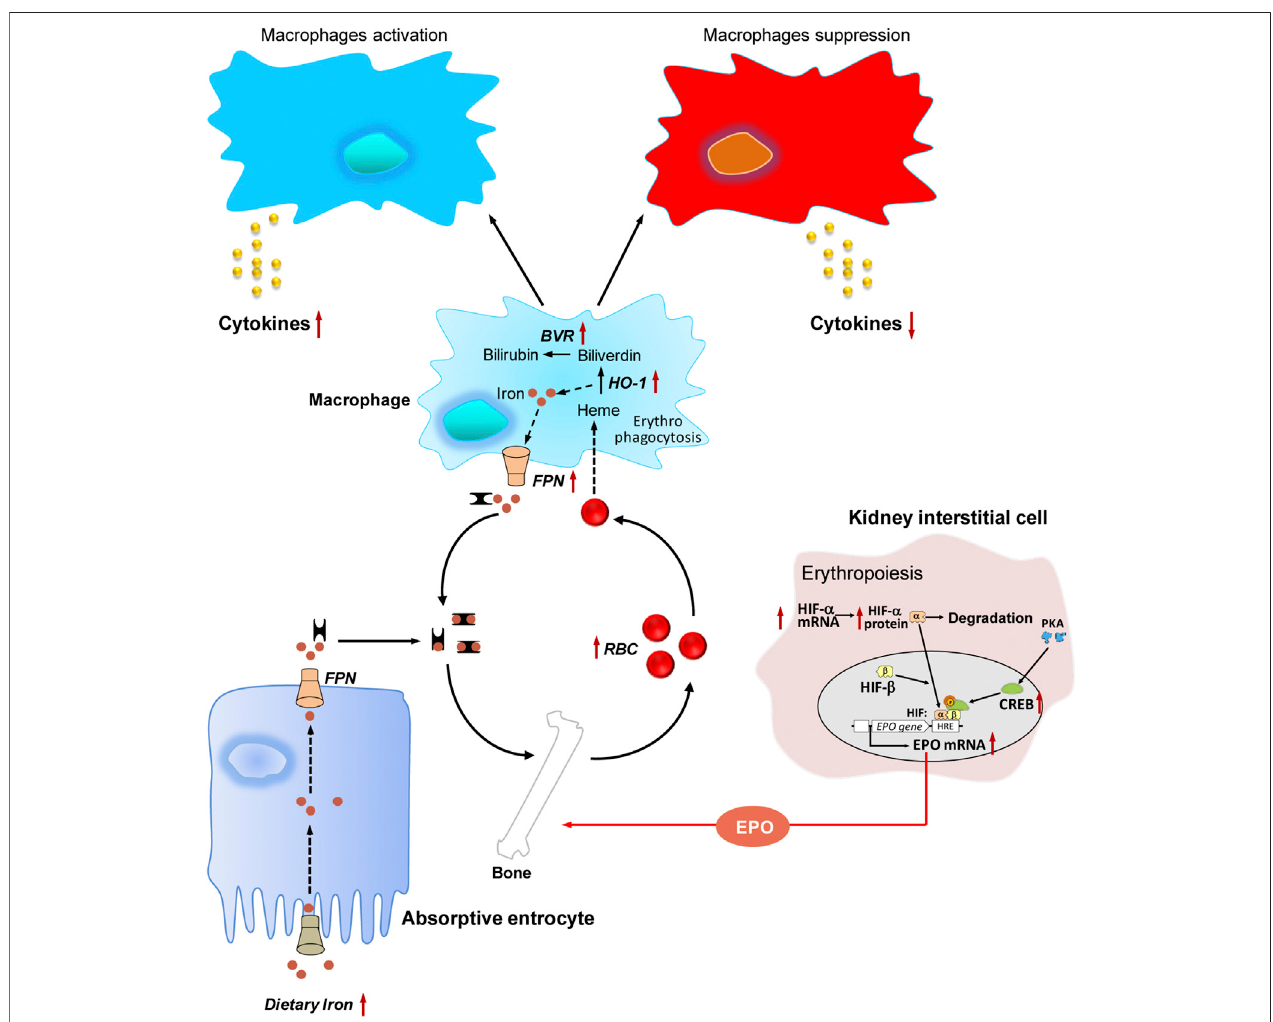
FIGURE 4 | The hematopoietic functions of jujube. Jujube promotes erythropoiesis via activation of hypoxia inducible factor-induced erythropoietin, possesses potential capacity in recycling heme iron during erythrophagocytosis, exhibits bidirectional role in regulating immune response under different conditions, contains numerous minerals including iron. Red dots indicate iron, and yellow dots indicate cytokine. The arrow in red indicates the targets for jujube action. RBC, red blood cell; EPO, erythropoietin; HIF, hypoxia inducible factor; HRE, hypoxia response element; PKA, protein kinase A; CREB, cAMP response element-binding protein; FPN, ferroportin; BVR, biliverdin reductase; HO-1, heme oxygenase-1.